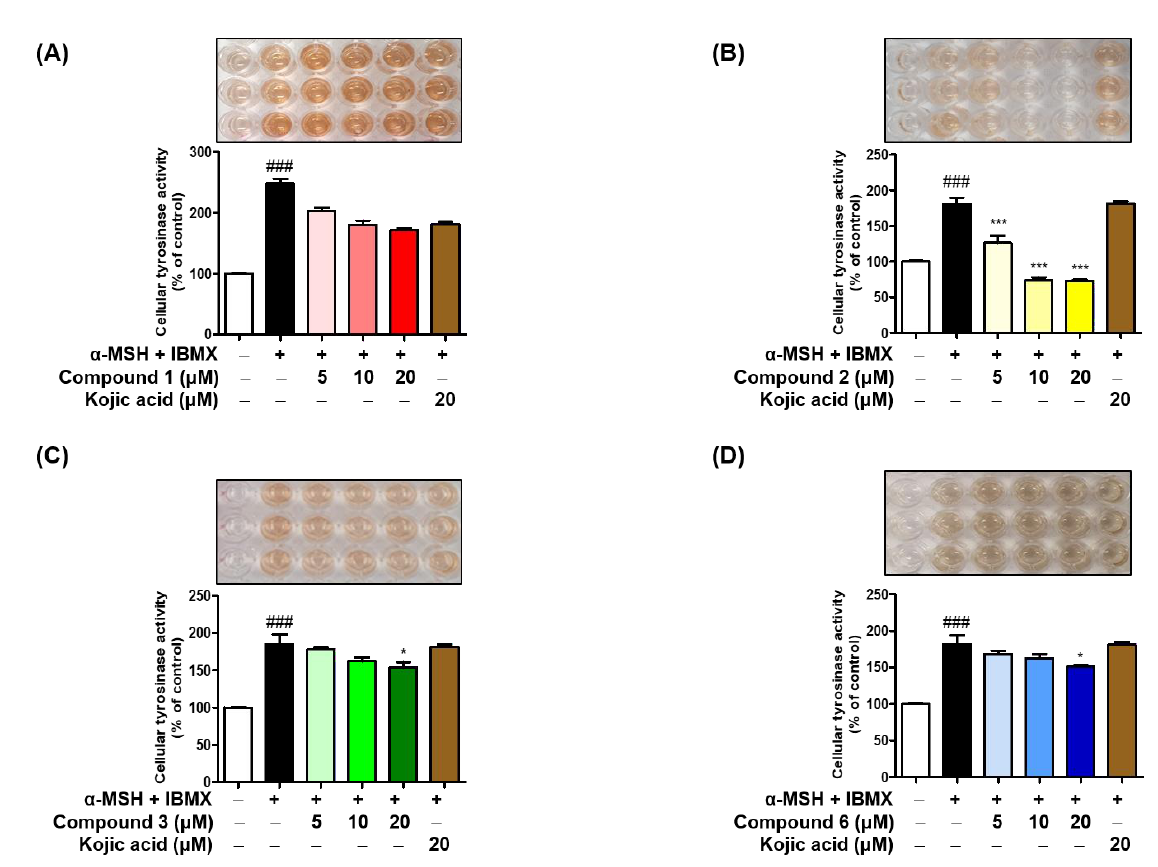
Figure 10. Inhibitory effect of analogs 1 – 3 and 6 on tyrosinase activity in B16F10 cells co-stimulated with α -MSH and IBMX. B16F10 cells were pretreated with analogs 1 – 3 ( A – C ), or 6 ( D ) at concentra- tions of 0, 5, 10, or 20 µM, or with kojic acid at 20 µM. Cellular tyrosinase activities are expressed as percentages of non-treated controls and bars represent standard errors. # and * indicate significant differences between columns: ### p < 0.001 for cells co-treated with α -MSH and IBMX versus non- treated controls; * p < 0.05, and *** p < 0.001 for cells co-treated with α -MSH and IBMX versus analogs 1 , 2 , 3 , 6 , or kojic acid pretreated and α -MSH plus IBMX co-treated cells. Three independent exper- iments were performed.